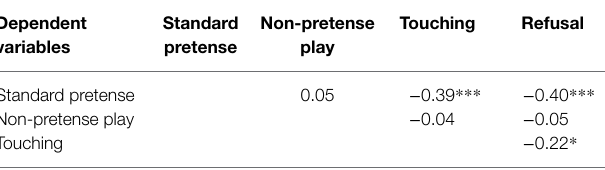
TABLE 2 | Correlation between the proportions of standard pretense, non- pretense play, touching, and refusal. Dependent variables